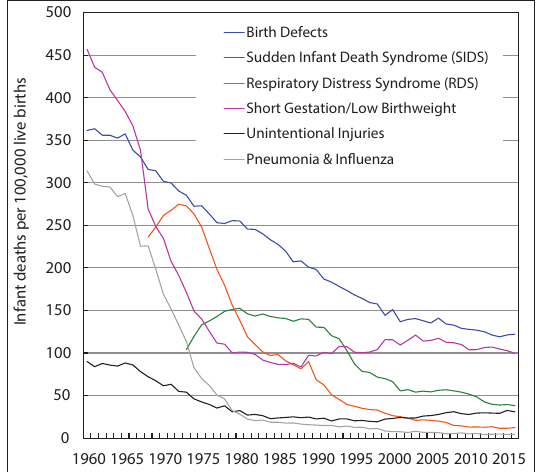
Figure 7 : Trends in Infant Mortality from Major Causes of Death, United States,1960-2016 Source: US National Vital Statistics